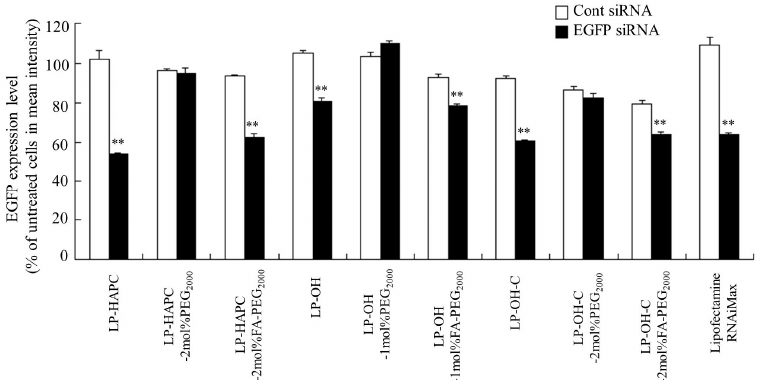
Figure 7. Effect of FA-PEG-modification of cationic liposomes on suppression of EGFP expression in KB-EGFP cells after transfection with FA-PEG-modified siRNA lipoplexes. As cationic liposomes, LP-HAPC, LP-HAPC-2mol%PEG 2000 , LP-HAPC-2mol%FA-PEG 2000 , LP-OH, LP-OH-1mol%PEG 2000 ,